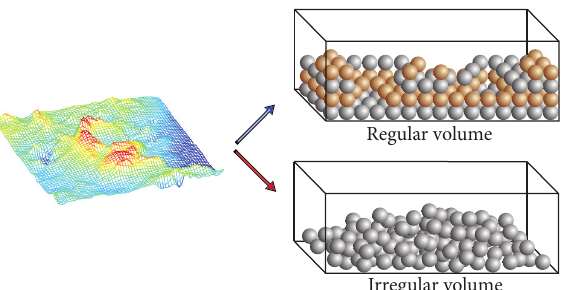
Figure 6: Two types of volume structures representing lunar soils (odd and even layers of voxels of the regular volume are shown in different color for a clear